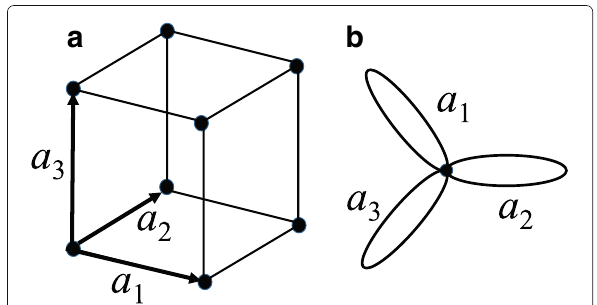
Fig. 1 Simple cubic (SC) lattice. ( a ) shows the unit cell of the SC lattice given by a 1 , a 2 and a 3 , whereas the lattice is also expressed by a graph with loops as in ( b )